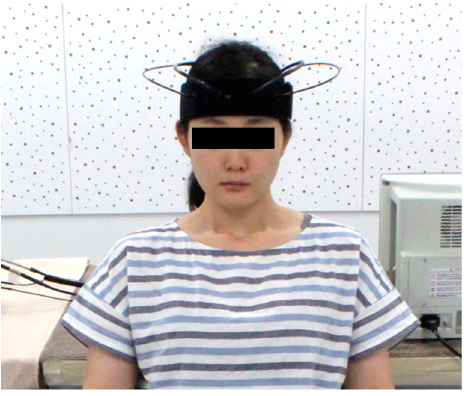
Figure 3. Participant undergoing near-infrared time-resolved spectroscopy measurement.